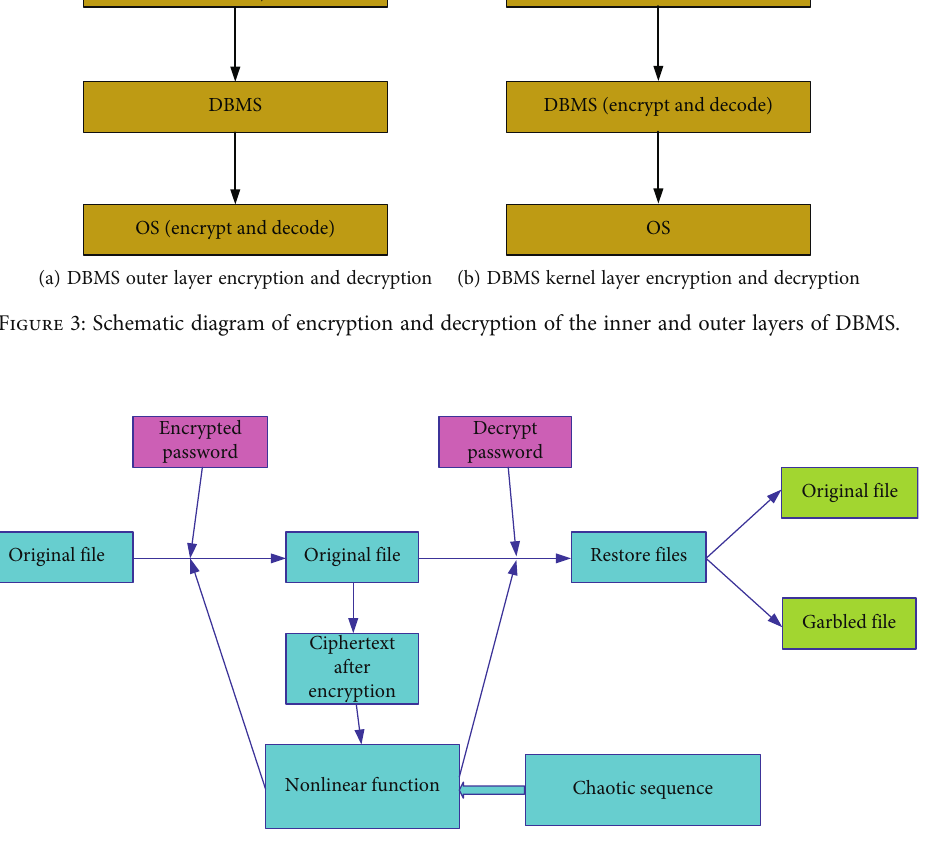
Figure 4: Schematic diagram of encryption